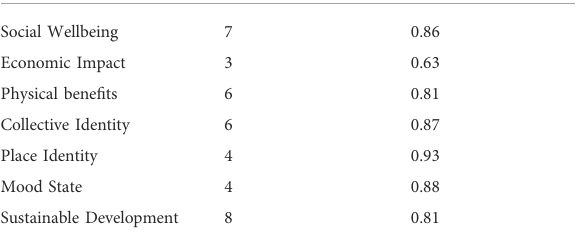
TABLE 1 Reliability of each variable included in the Social Impact framework.